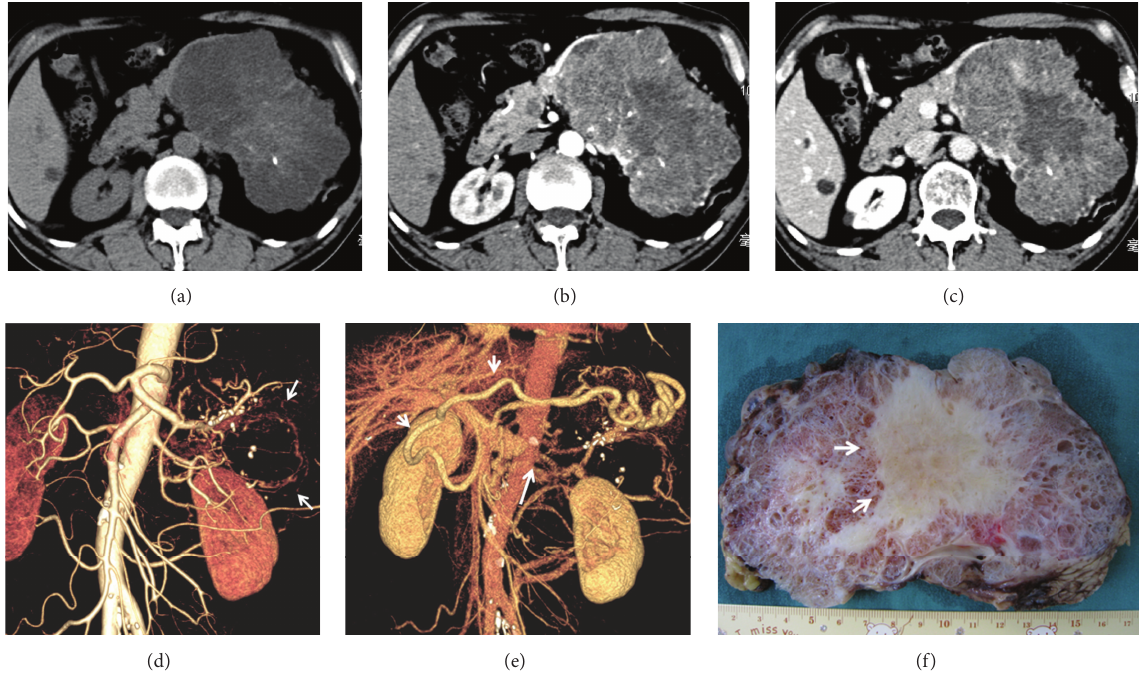
Figure 2: A 67-year-old male patient with a giant serous cystadenoma of the pancreas. (a) A low-density, lobulated tumor with dotted calcification and isodense central scar was noted on CT plain scanning. (b) The tumor showed early enhancement on arterial phase image. (c) The honeycomb-like tumor displayed decreased enhancement on portal phase image with a hypodense central scar. (d) CTA showed the feeding splenic artery and draining veins (arrow) on the tumor surface. (e) Portal phase vascular reconstruction showed left gastric vein varices (short arrow) and splenic vein stenosis (long arrow). (f) Tumor specimens displayed a honeycomb-like appearance with abundant central